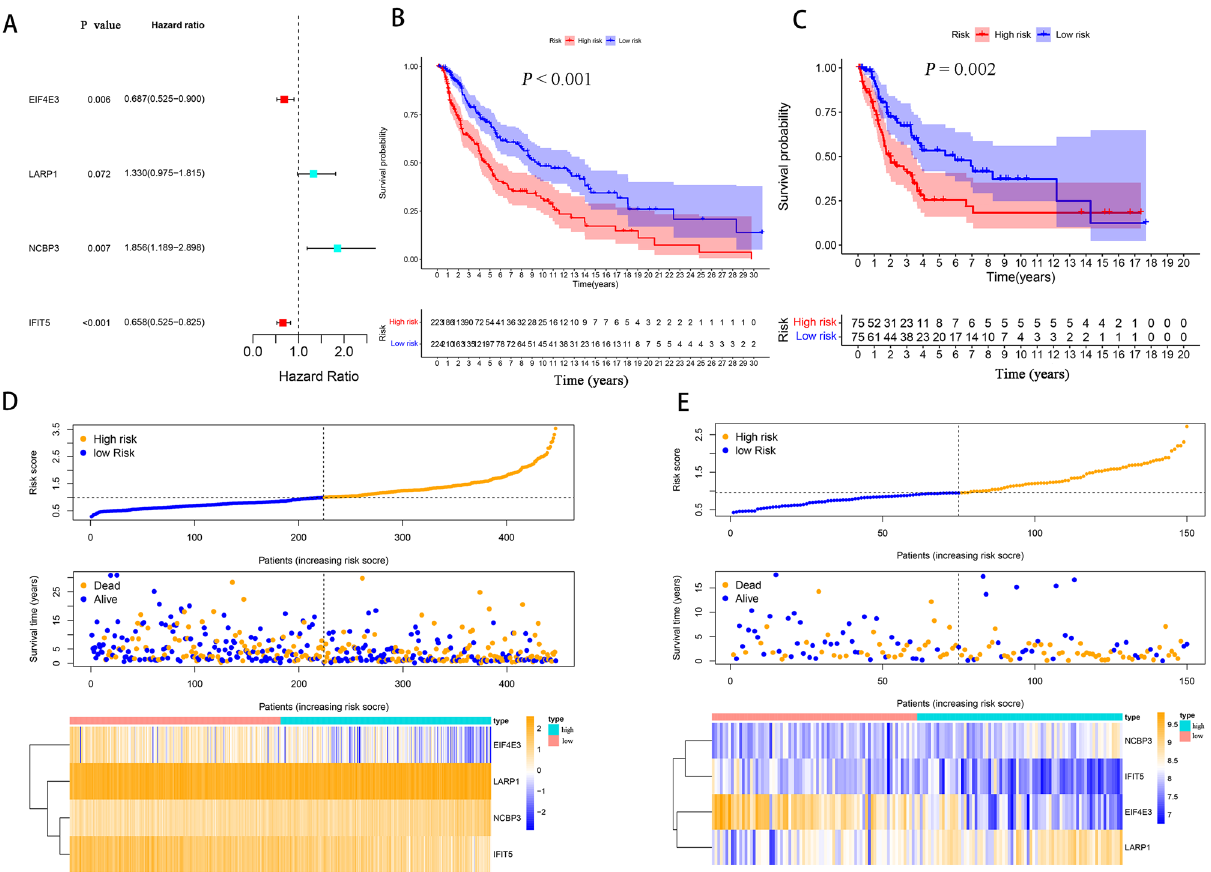
Figure 3. Construction of an prognostic prediction model for melanoma patients. ( A ) HR and P values of the four m 7 GMRRGs in the prognostic model. ( B ) Survival curves of patients in the high- and low-risk subgroups of the training set. ( C ) Validation of survival curves for patients in the pooled high-risk and low-risk subgroups. ( D ) Distribution of risk scores, survival status, and RNA expression of the four m 7 G regulator genes between the high-risk and low-risk subgroups in the training set. The top panel shows patients’ risk scores. The middle panel depicts patients’ survival status and survival time distributed by risk score. The bottom panel shows the braided hotspots for the four predictors by risk score. ( E ) Distribution of risk scores, survival status, and RNA expression of the four m 7 G regulator genes between the high-risk and low-risk subgroups in the validation set. m 7 GMRRGs N7-methylguanosine (m 7 G) methylation-related regulator genes.